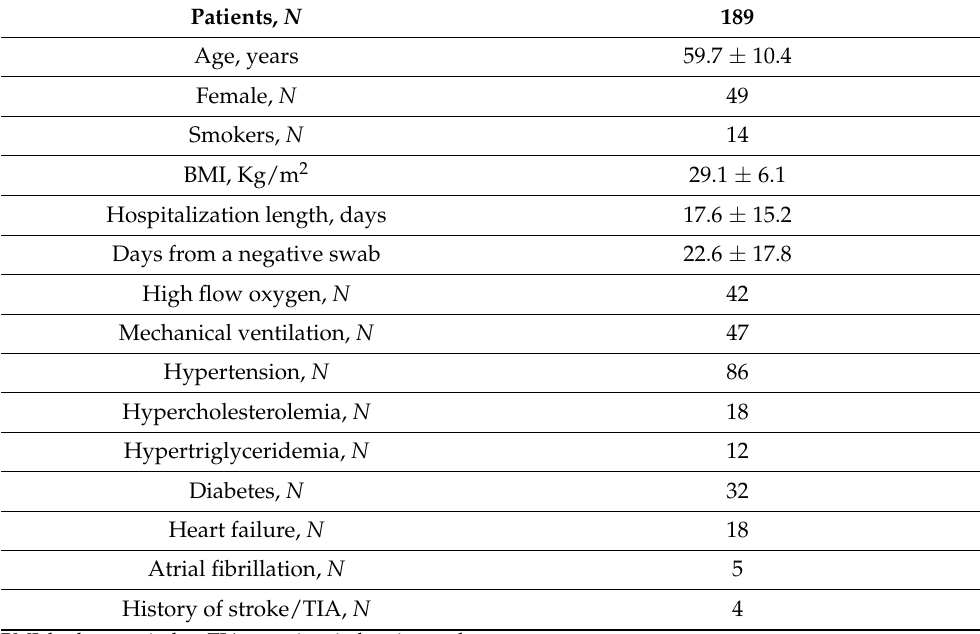
Table 1. Baseline demographic and clinical characteristics of post-acute COVID-19 patients.